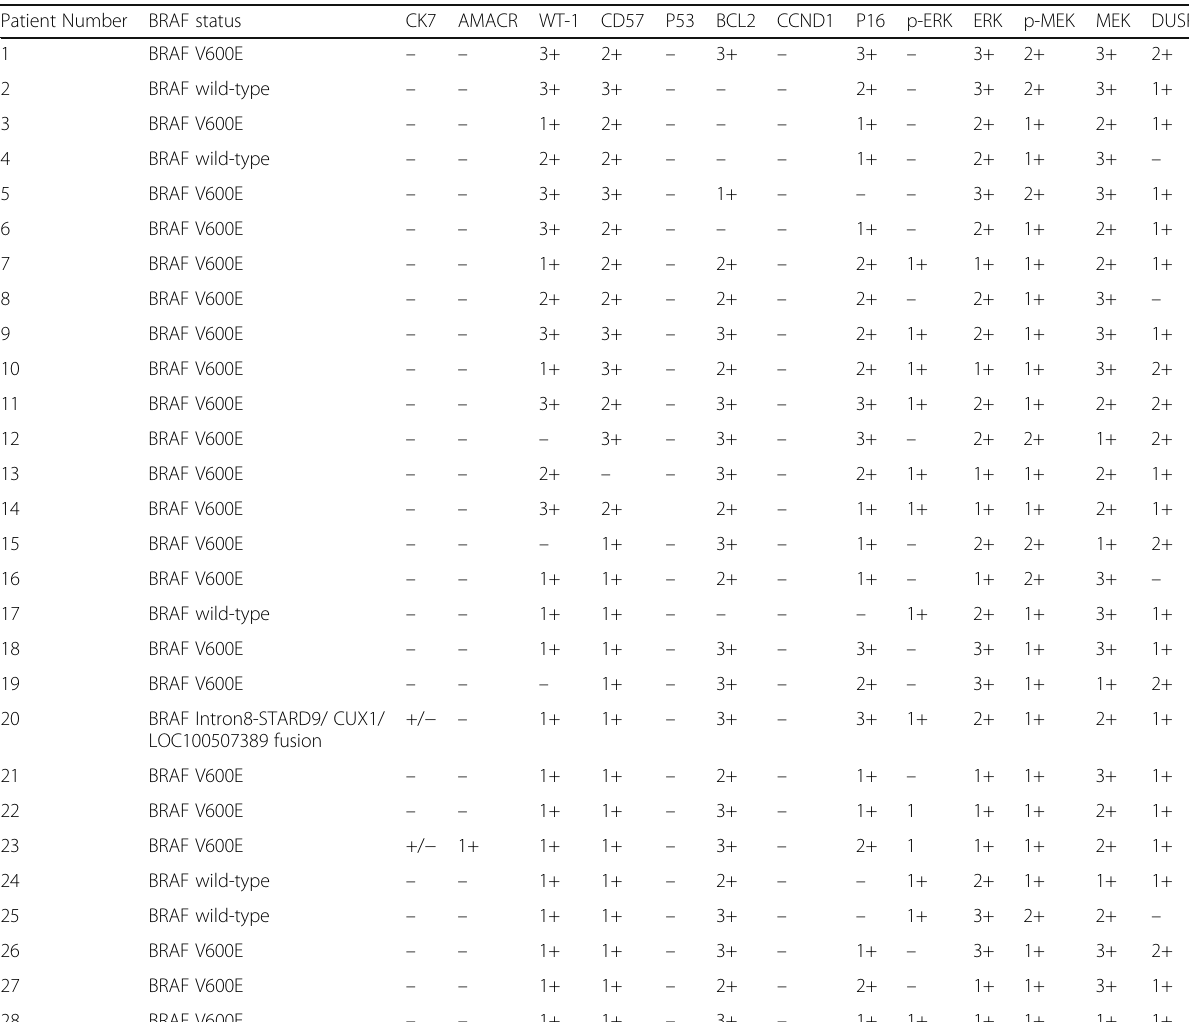
Table 5 Immunohistochemical characteristics Patient Number BRAF